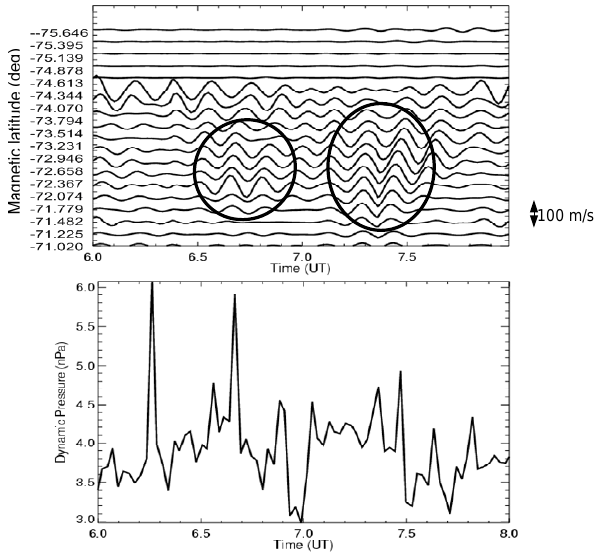
Fig. 8. The top panel shows the HF radar velocity time series at different latitudes while the arrow on the right shows the magnitude of velocity. The two ellipses highlight the velocity enhancement. The bottom panel is the dynamic pressure deduced from data from WIND